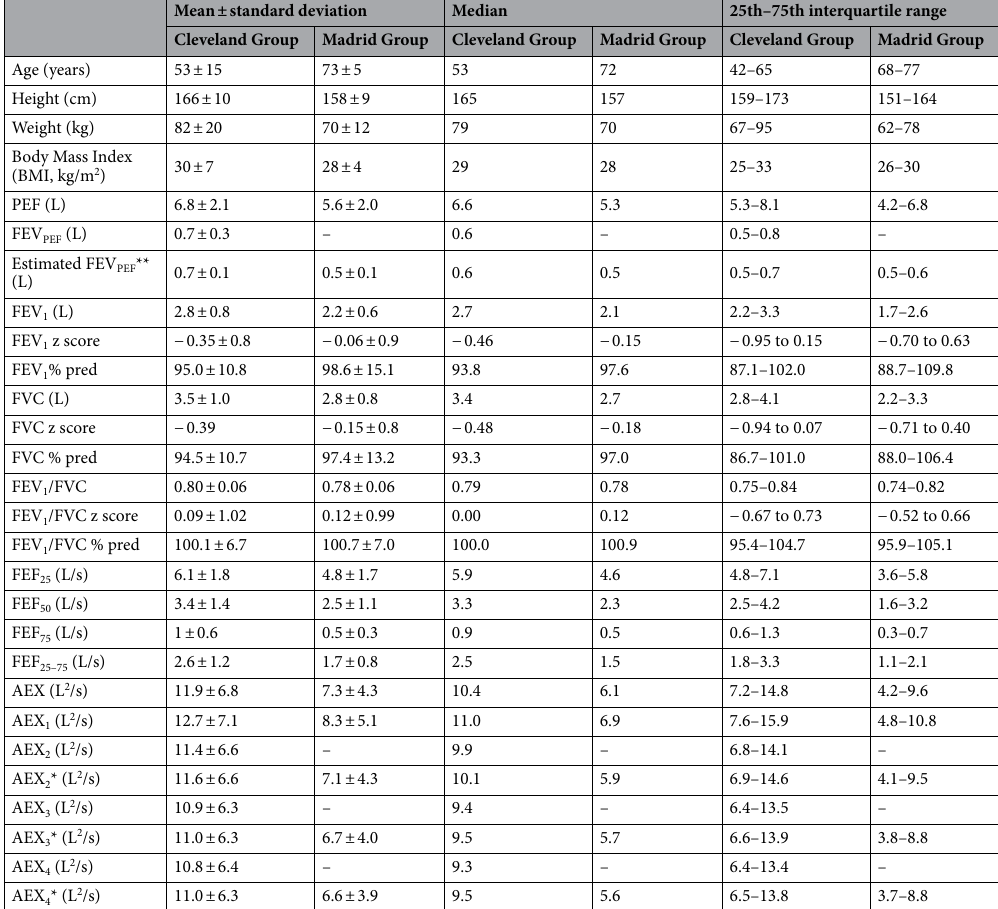
Table 1. Demographic and functional characteristics of the study participants. *Depicts AEX 2 , AEX 3 and AEX 4 obtained based on an Estimated FEV PEF **, as this variable was not available in the Madrid group. The formula used was: estimated FEV PEF ** = 0.157174 + 0.176439*FEV 1 and was derived in the Cleveland group by modeling the variable based on FEV 1 only. The coefficient of correlation between actual FEV PEF and Estimated FEV PEF ** was 0.54, standard deviation of the difference was 0.12, p <